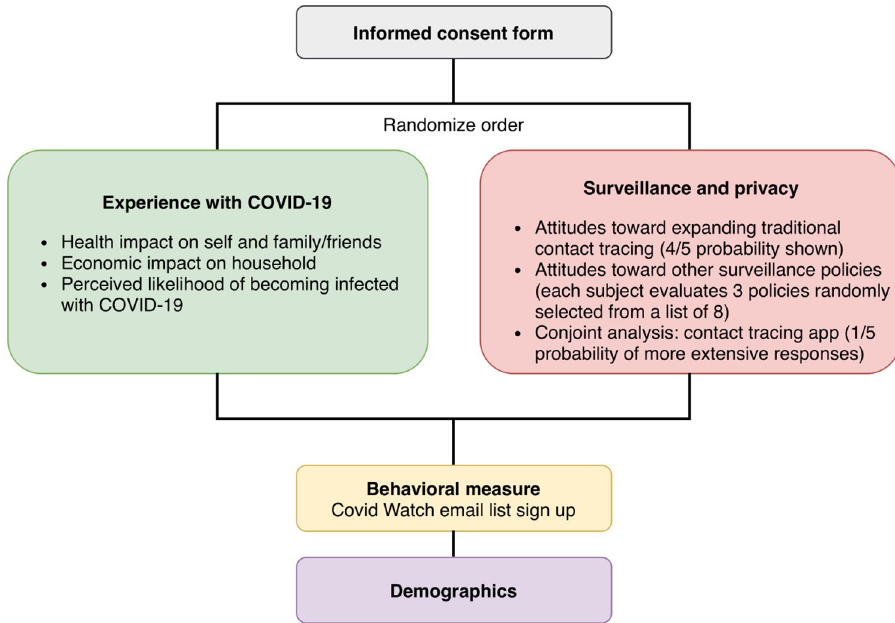
Fig 1. Survey flowchart. The figure illustrates the survey